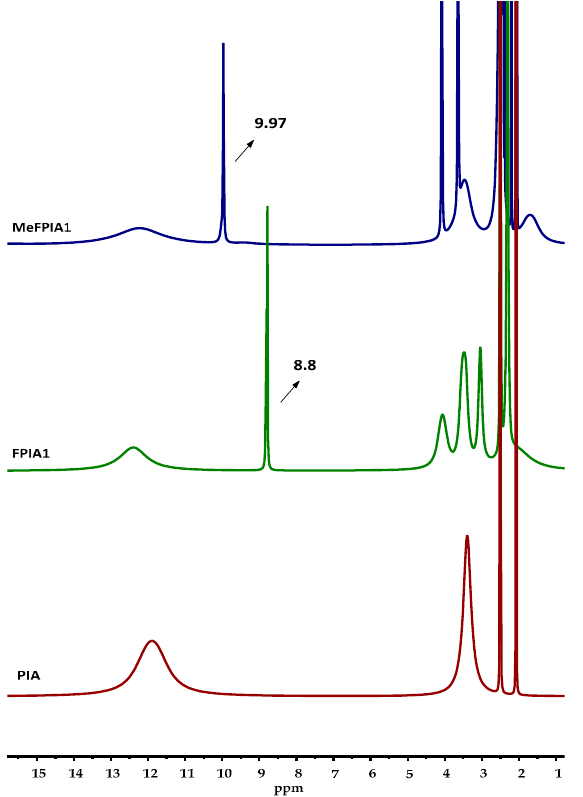
Figure 1. Proton nuclear magnetic resonance ( 1 H-NMR) spectra of poly(itaconic acid) (PIA), func- tionalized polymer (FPIA1), and quaternized polymer (MeFPIA1). tionalized polymer (FPIA1), and quaternized polymer